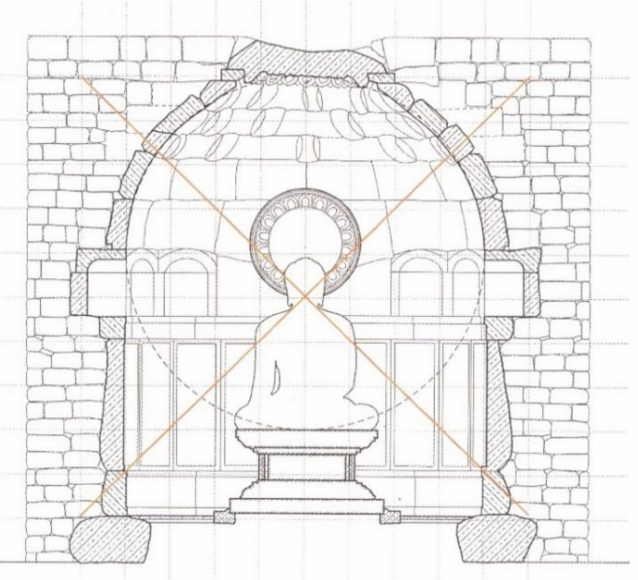
Figure 20. Vertical proportions of Seokguram showing the precise location in the center of the head of the